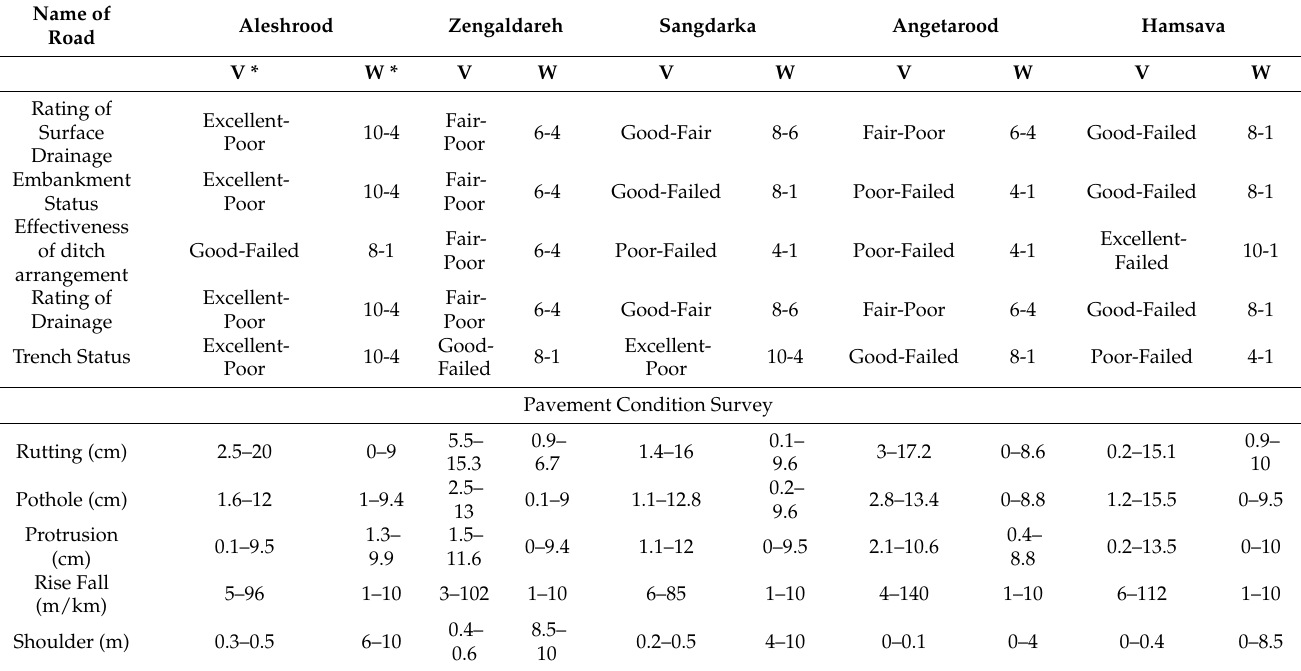
Table 4. Weightings (V and W showed value and weighting of each